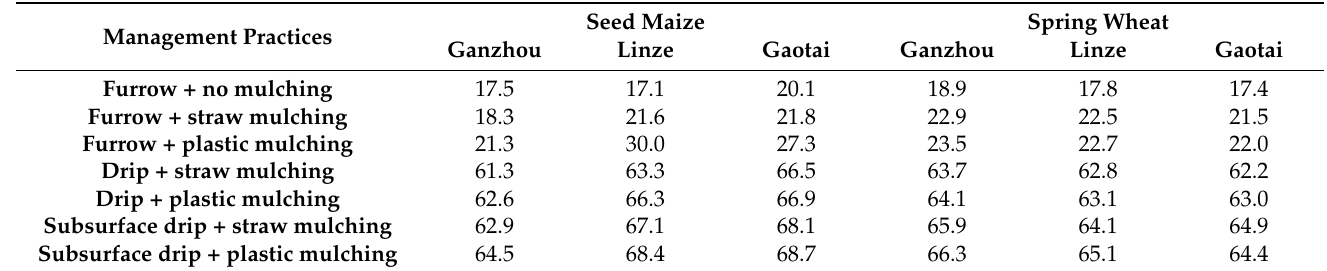
Table 6. Reduction in irrigation water extraction (%) under different combinations of irrigation methods and soil